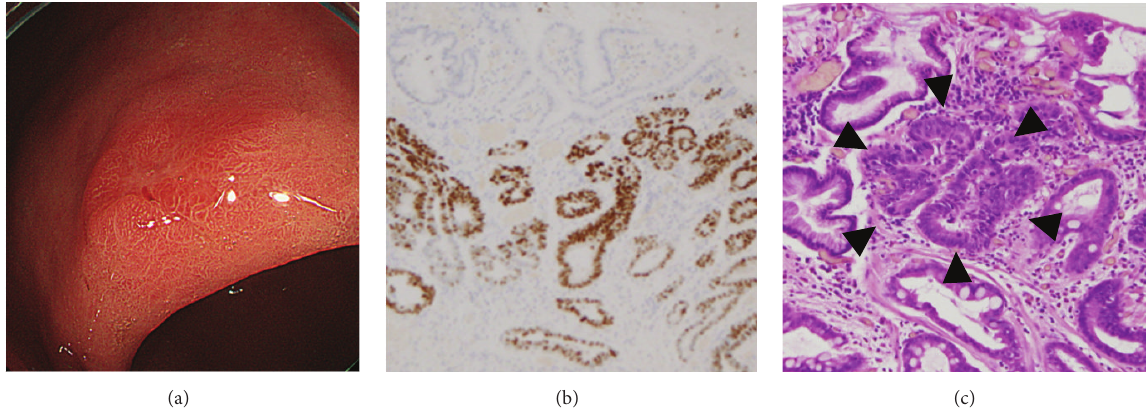
Figure 1: A typical case of EGC diagnosed after successful H. pylori eradication treatment. EGD indicated a depressed (0-IIc), reddish lesion in the lesser curvature of the gastric corpus (a). Diagnosis of neoplastic or nonneoplastic lesion was difficult by the targeted biopsy during the pretreatment EGD. Histological assessment of resected specimen showed nonneoplastic epithelium covering the cancerous tissue, (b) and (c). (b) TP53 immunohistochemistry; (c) hematoxylin and eosin stain. Cancer crypts were indicated by the black arrowhead.